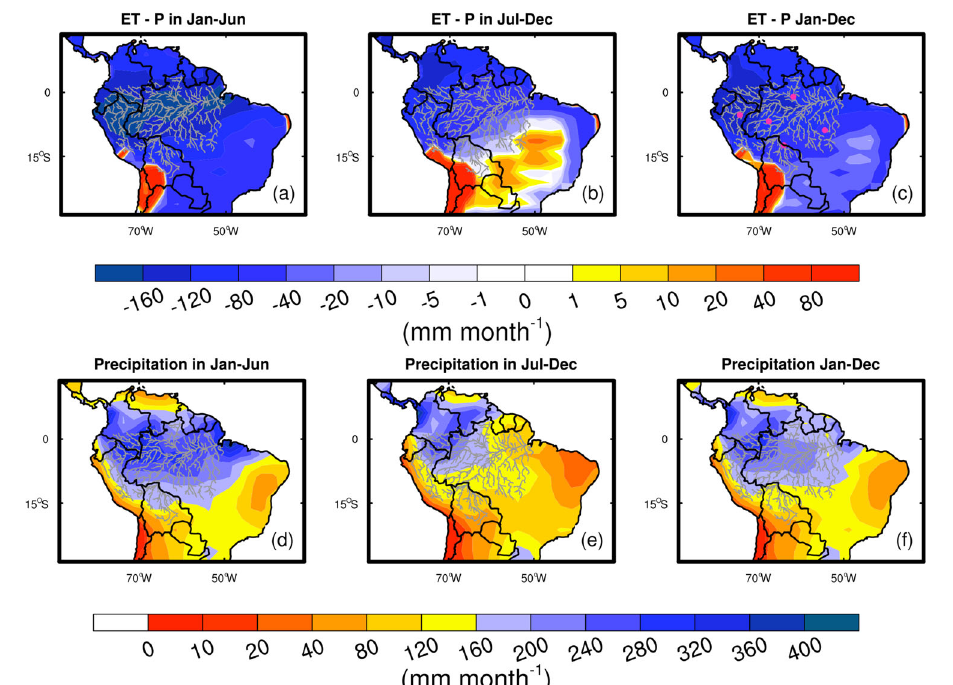
Fig. 4 The spatial pattern of ET-P and precipitation over the Amazon. Here, we show the ET-P (mm month − 1 ) derived from the TWS/discharge versus AIRS δ D _004 relationship for a the wet season (January – June), b the dry season (July – December), and c the yearly average during 2013 – 2019. Mean precipitation for d the wet season (January – June), e the dry season (July – December), and f the annual average is obtained from the monthly record of GPCP during 2013 – 2019. The pink dots in panel c indicate the center of fi ve basin groups ( “ Methods ” ). In Figures ( d – f ), we use the colder colors to indicate areas with annual precipitation over 160 mm month − 1 , which is the dry-to-wet criterion of the tropics as suggested by Guan et al.